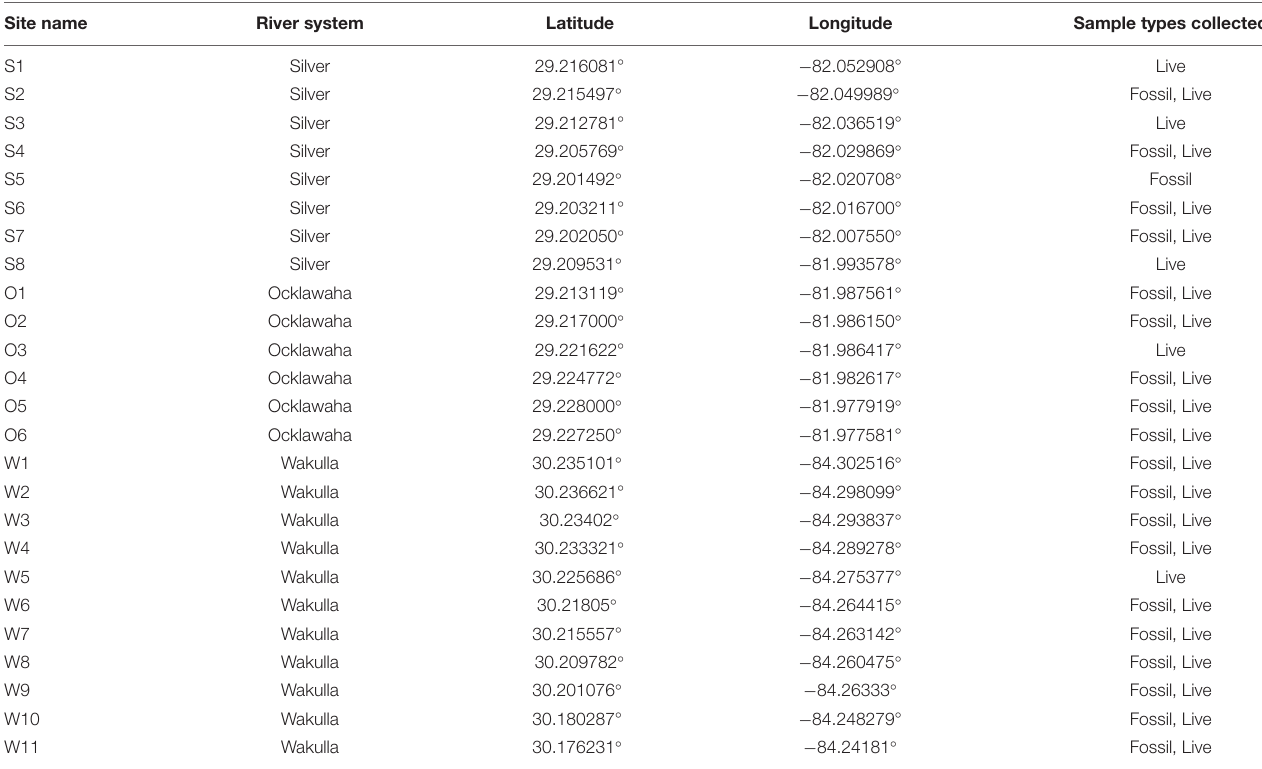
TABLE 1 | Latitude, longitude (datum WGS 84), and types of samples collected at each